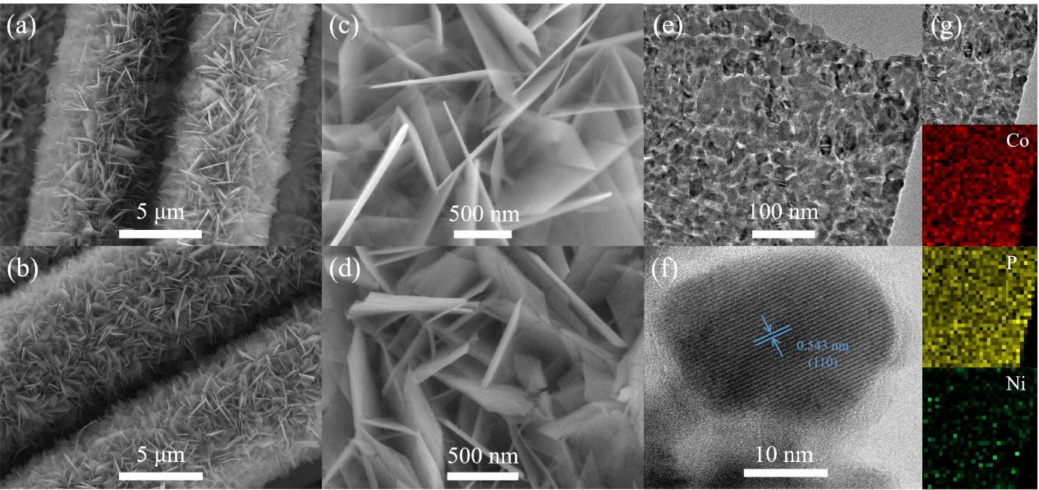
Figure 2. ( a , c ) SEM images of Ni-doped cobalt precursor NWAs/CC. ( b , d ) SEM images of Ni-CoP 3 -7 NWAs/CC. ( e ) TEM and ( f ) HRTEM images of Ni-CoP 3 -7 NWAs/CC. ( g ) TEM and corresponding elemental mapping images of Ni, Co, and P for Ni-CoP 3 -7